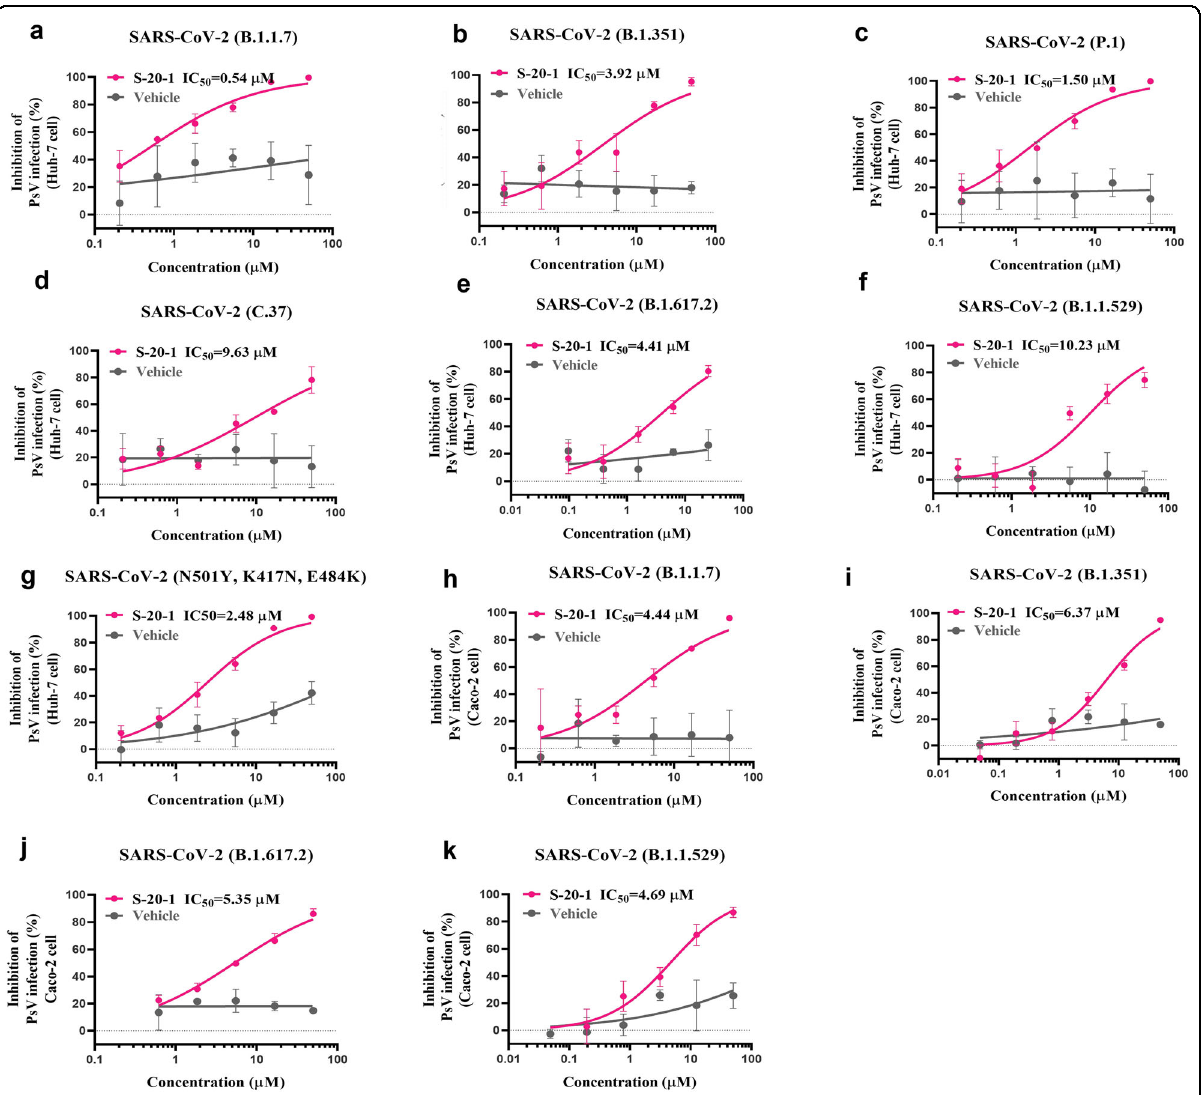
Fig. 3 Inhibition of S-20-1 against infection by pseudotyped SARS-CoV-2 variants in different cell lines. Inhibition of infection by PsV of SARS- variants on Huh-7 cells: a B.1.1.7 (Alpha), b B.1.351 (Beta), c P.1 (Gamma), d C.37 (Lambda), e B.1.617.2 (Delta), f B.1.1.529 (Omicron), g mutant with N501Y, K417N, and E484K mutation. Inhibition of infection by PsV of SARS-variants on Caco-2 cells: h B.1.1.7 (Alpha), i B.1.351 (Beta), j B.1.617.2 (Delta), and k B.1.1.529